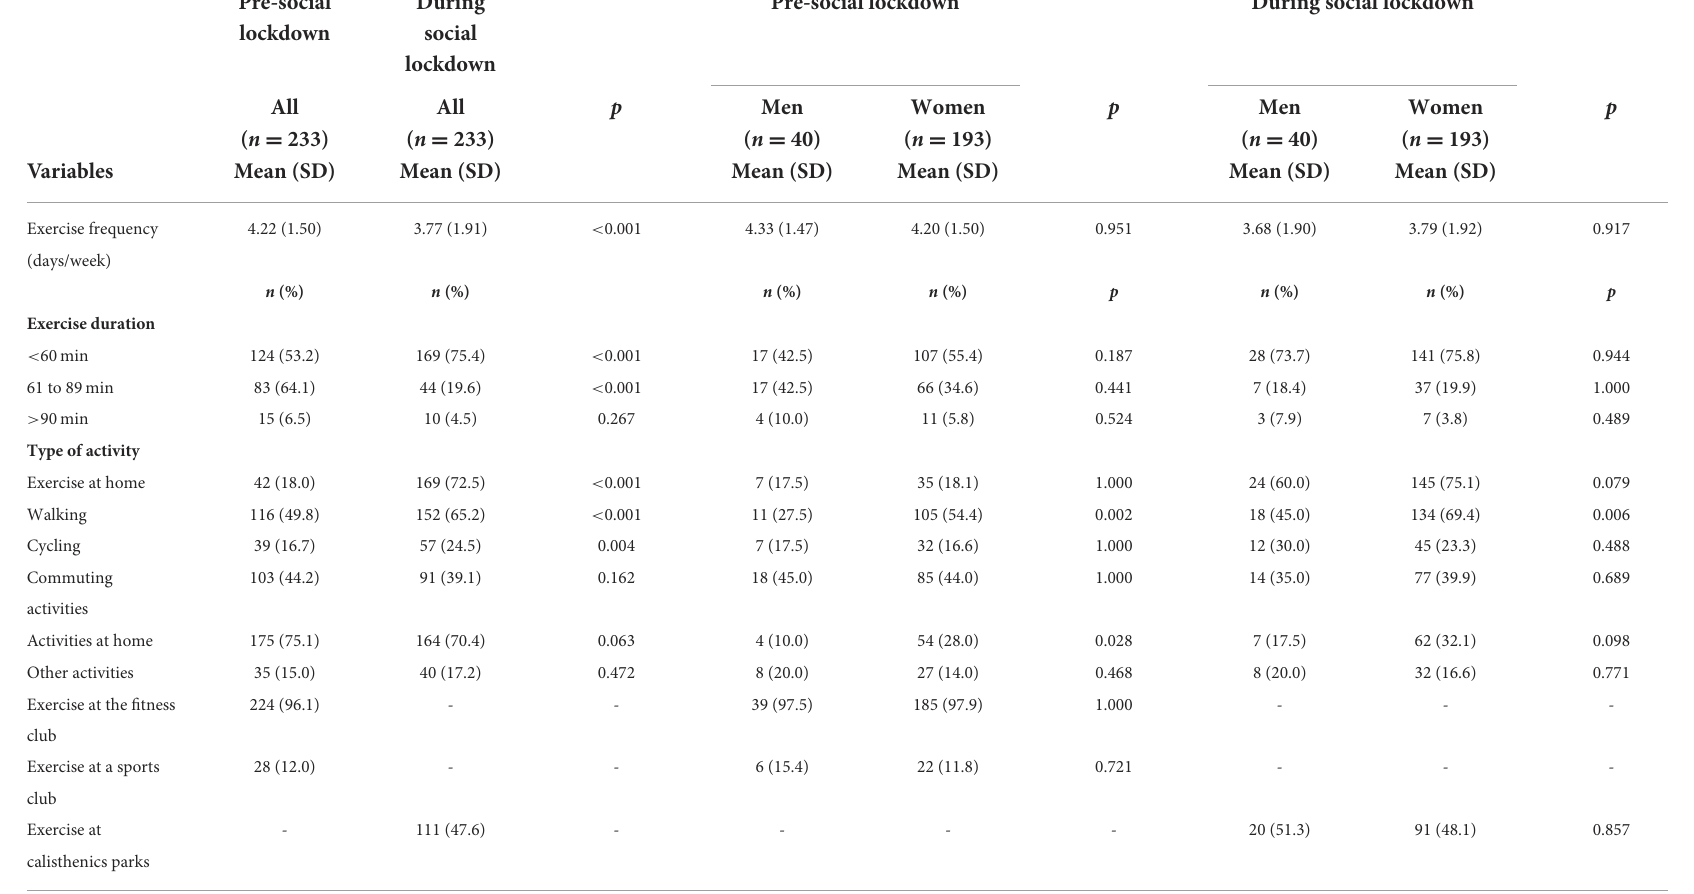
TABLE 3 Comparison of exercise habits pre- and during